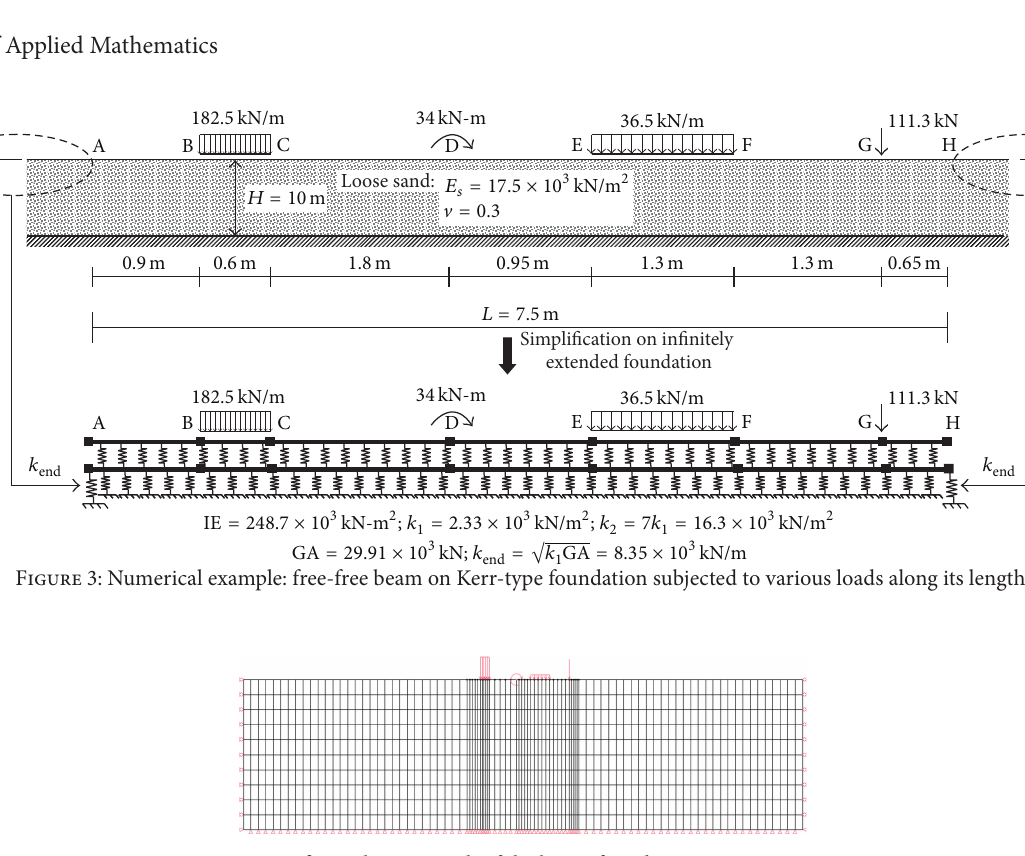
Figure 4: 2D finite element mesh of the beam-foundation system in Figure